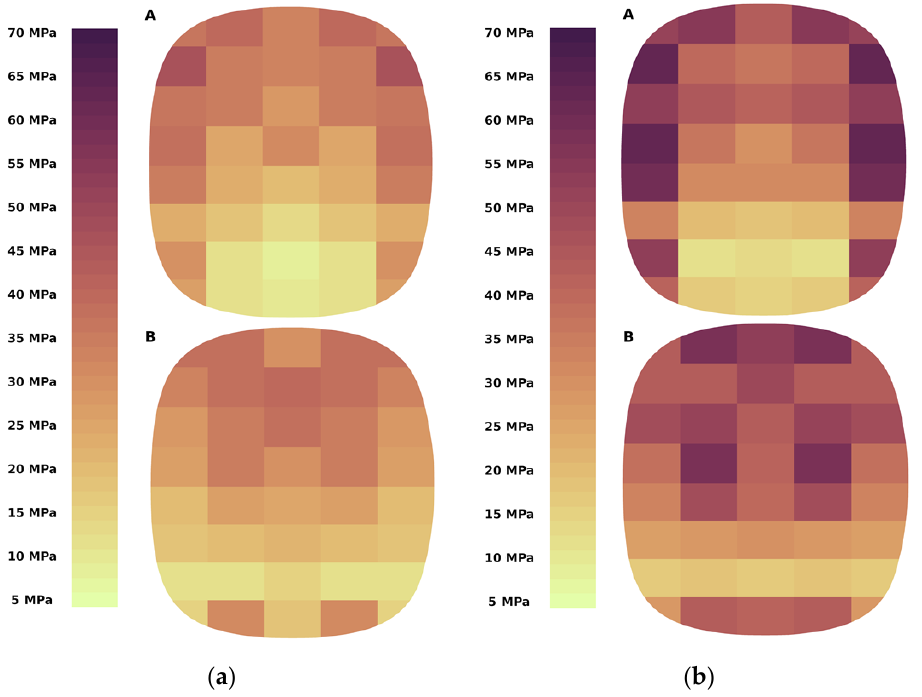
Figure 6. Stress distribution on forming surfaces for briquetting at the peripheral speed v = 0.1 m/s, A—cavity, B—groove: ( a ) calcium hydroxide; ( b ) copper ore concentrate. A—cavity, B—groove: ( a ) calcium hydroxide; ( b ) copper ore concentrate.